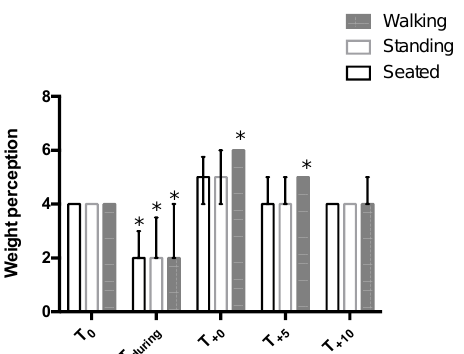
Figure 4. Group median along with the 25th and 75th percentile scores of weight perception during sitting, standing, and walking across different time intervals for the unloading condition. * Significant difference ( p < 0.05) relative to T 0 of the corresponding condition.